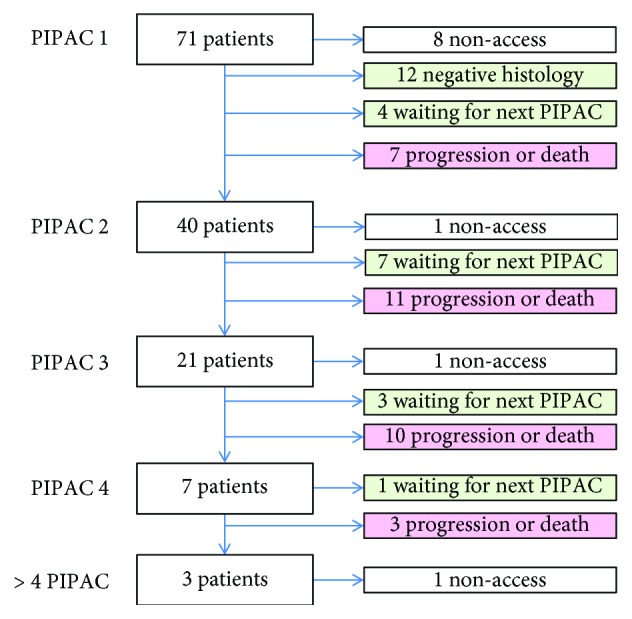
Patient flowchart.